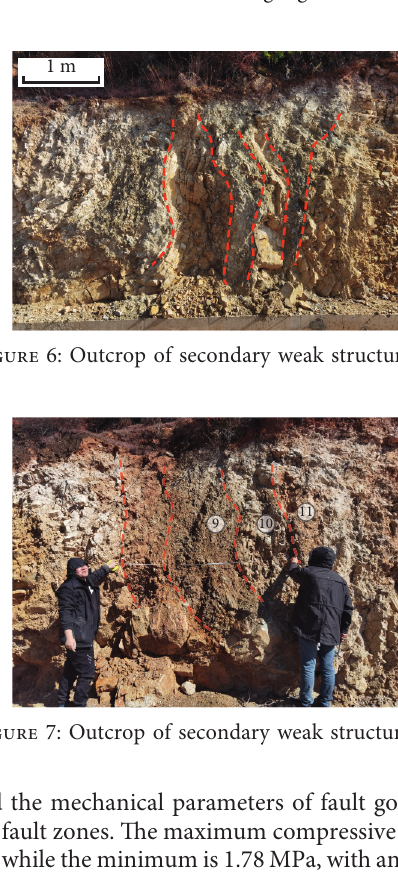
Figure 5: Fault gouge and lens of secondary weak structure A. (a). Fault gouge (b). Lens.